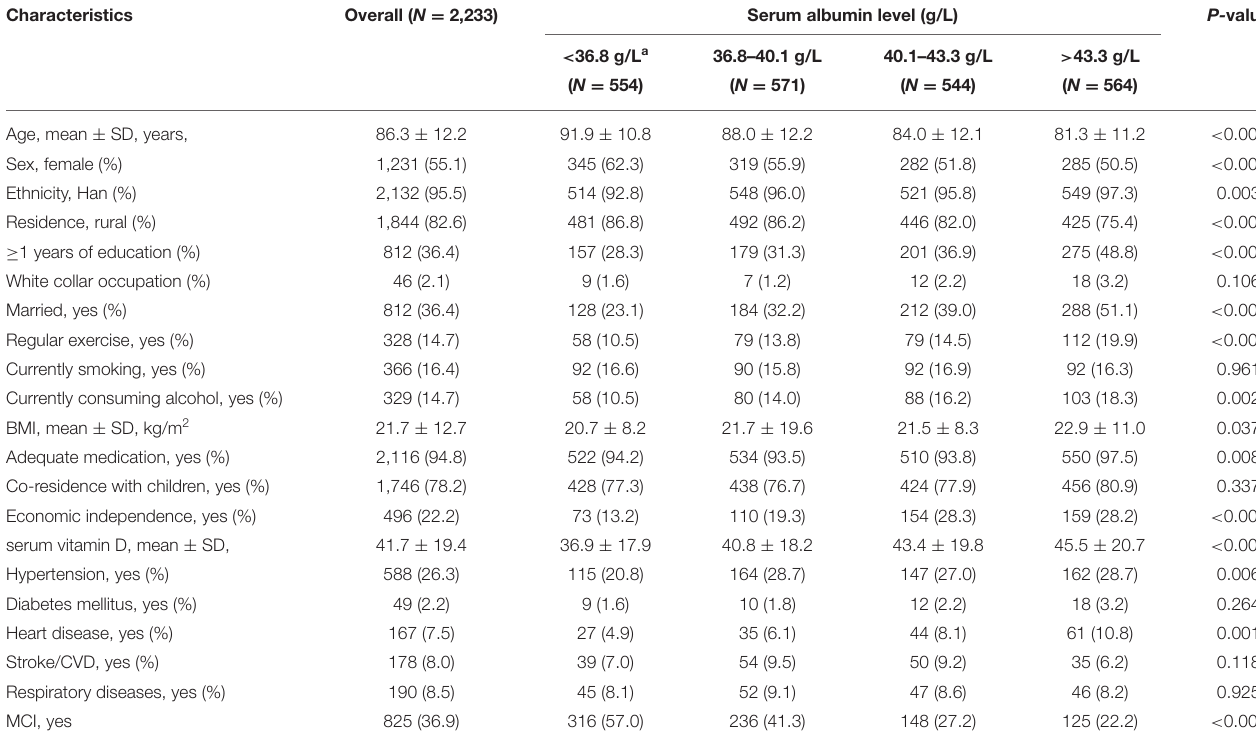
TABLE 1 | Basic characteristics of study participants by serum albumin quartiles.